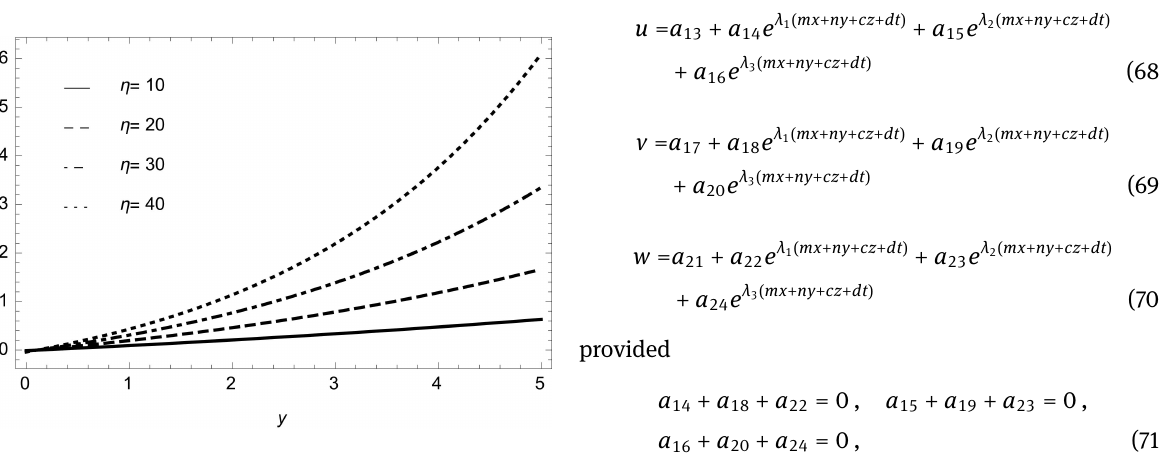
Fig. 2. Effect of couple stress for vertical component of velocity versus y ( m = 1, U 0 = v 0 = 2)